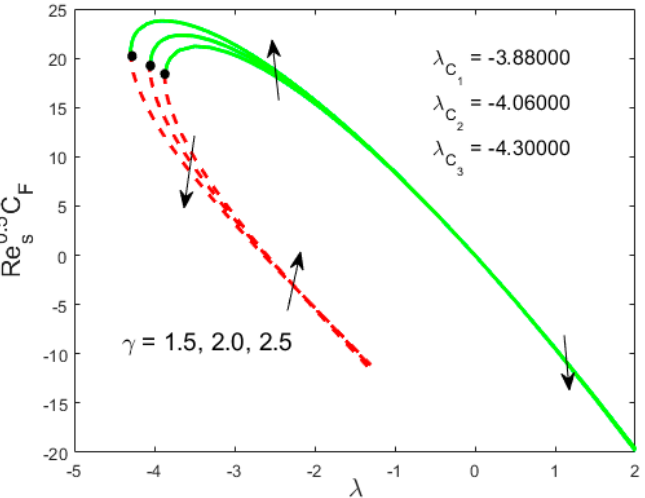
Figure 20. The impact of γ on Re 0.5 s C F versus λ .